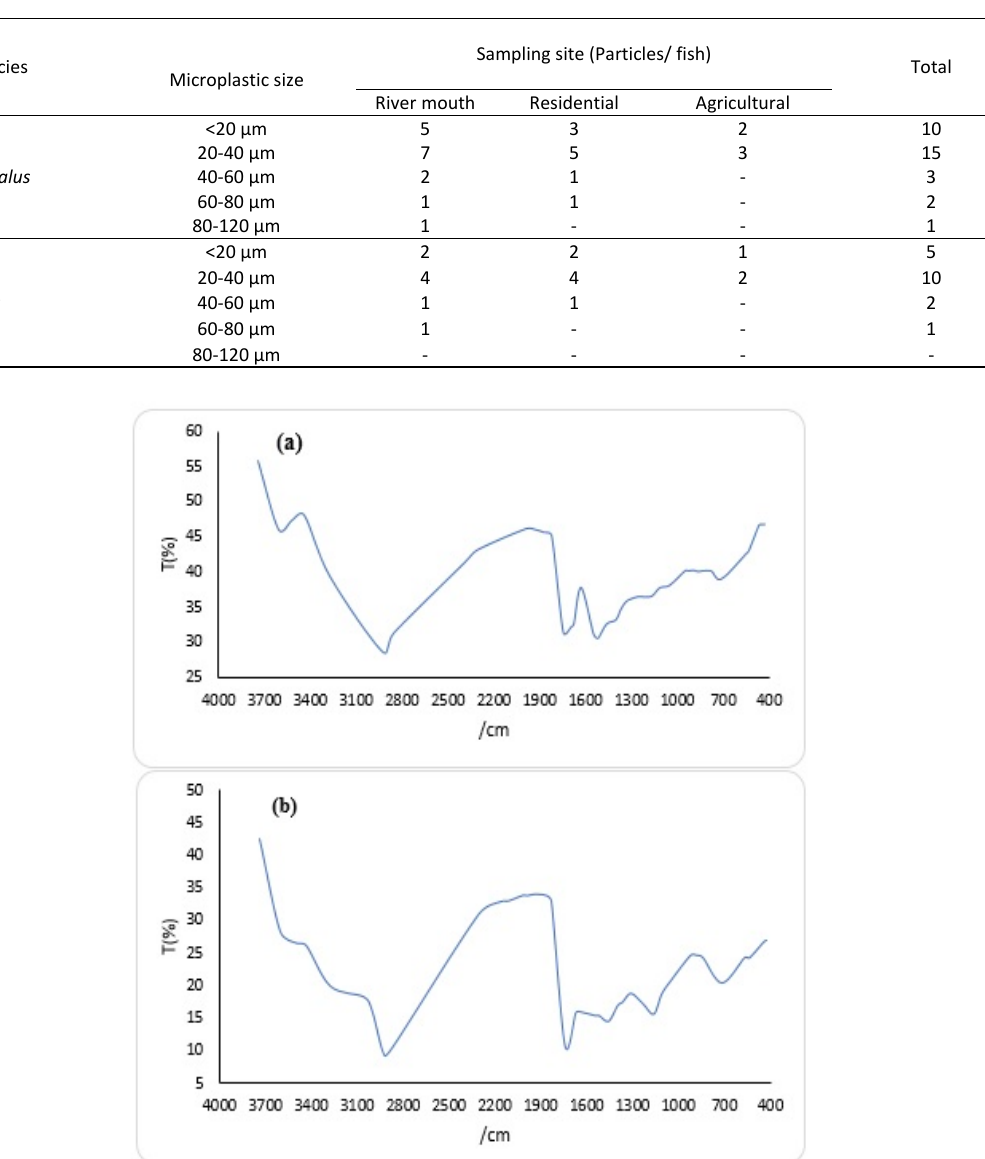
Table 3: The size ranges of the microplastic found in the alimentary tract of the mullet Mugil cephalus and bagok catfish Hexanematichthys sagor according to location.